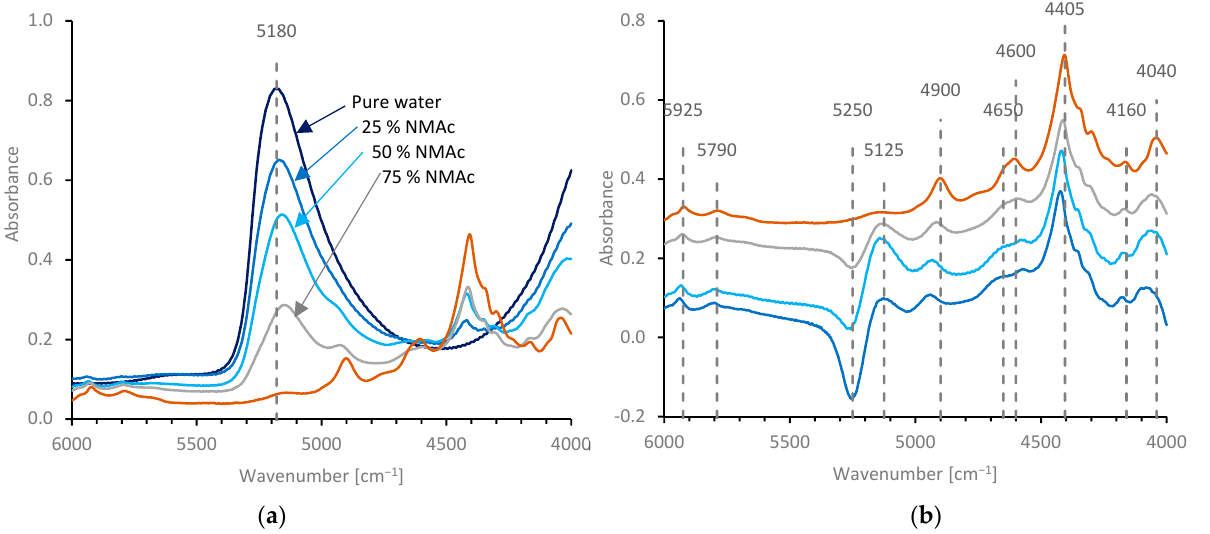
Figure 7. ( a ) NIR spectra for dry NMAc (brown) and aqueous NMAc solutions of the compositions indicated, collected in transmission geometry; ( b ) difference spectra after subtracting the expected water contributions and scaling to match the intensity of the peak around 4405 cm − 1 . The same colours are used for the specimens in both graphs and the plots in ( b ) have been off-set vertically for ease of viewing.